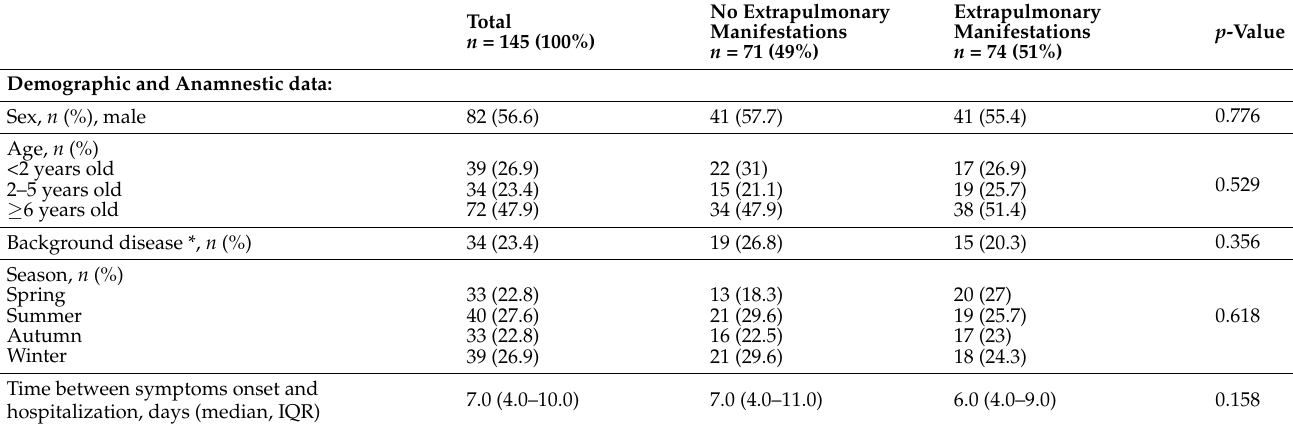
Table 2. Demographic, laboratory, and clinical features of MP patients with and without extrapulmonary